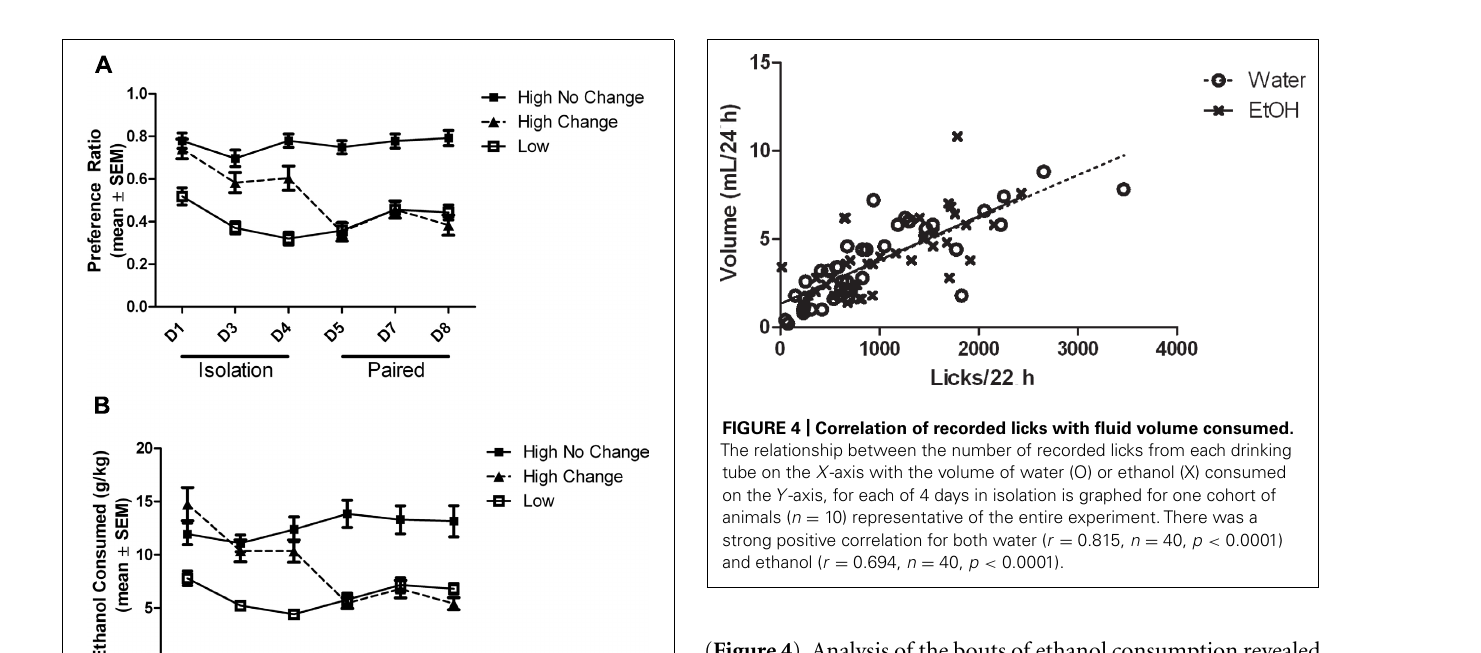
( Figure 4 ). Analysis of the bouts of ethanol consumption